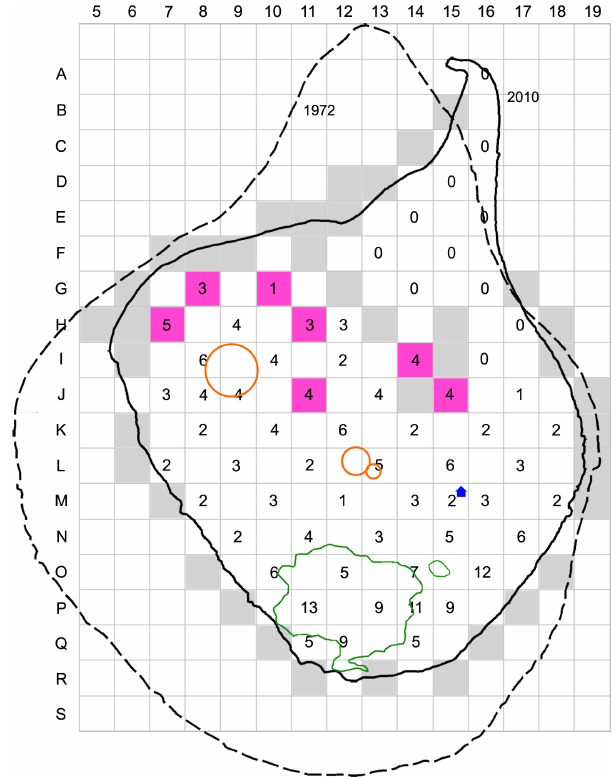
Figure 1. Number of bryophyte species found in each searched quadrat (100m × 100m) in 2008. Quadrats filled with light grey colour were deemed inaccessible. Quadrats filled with pink colour had visible steam emission. Orange circles indicate the craters and green polygons show where there is dense vegetation and a colony of seagulls. The blue house indicates the location of the research facilities and helicopter platform (M15). Maps: Anette Meier and